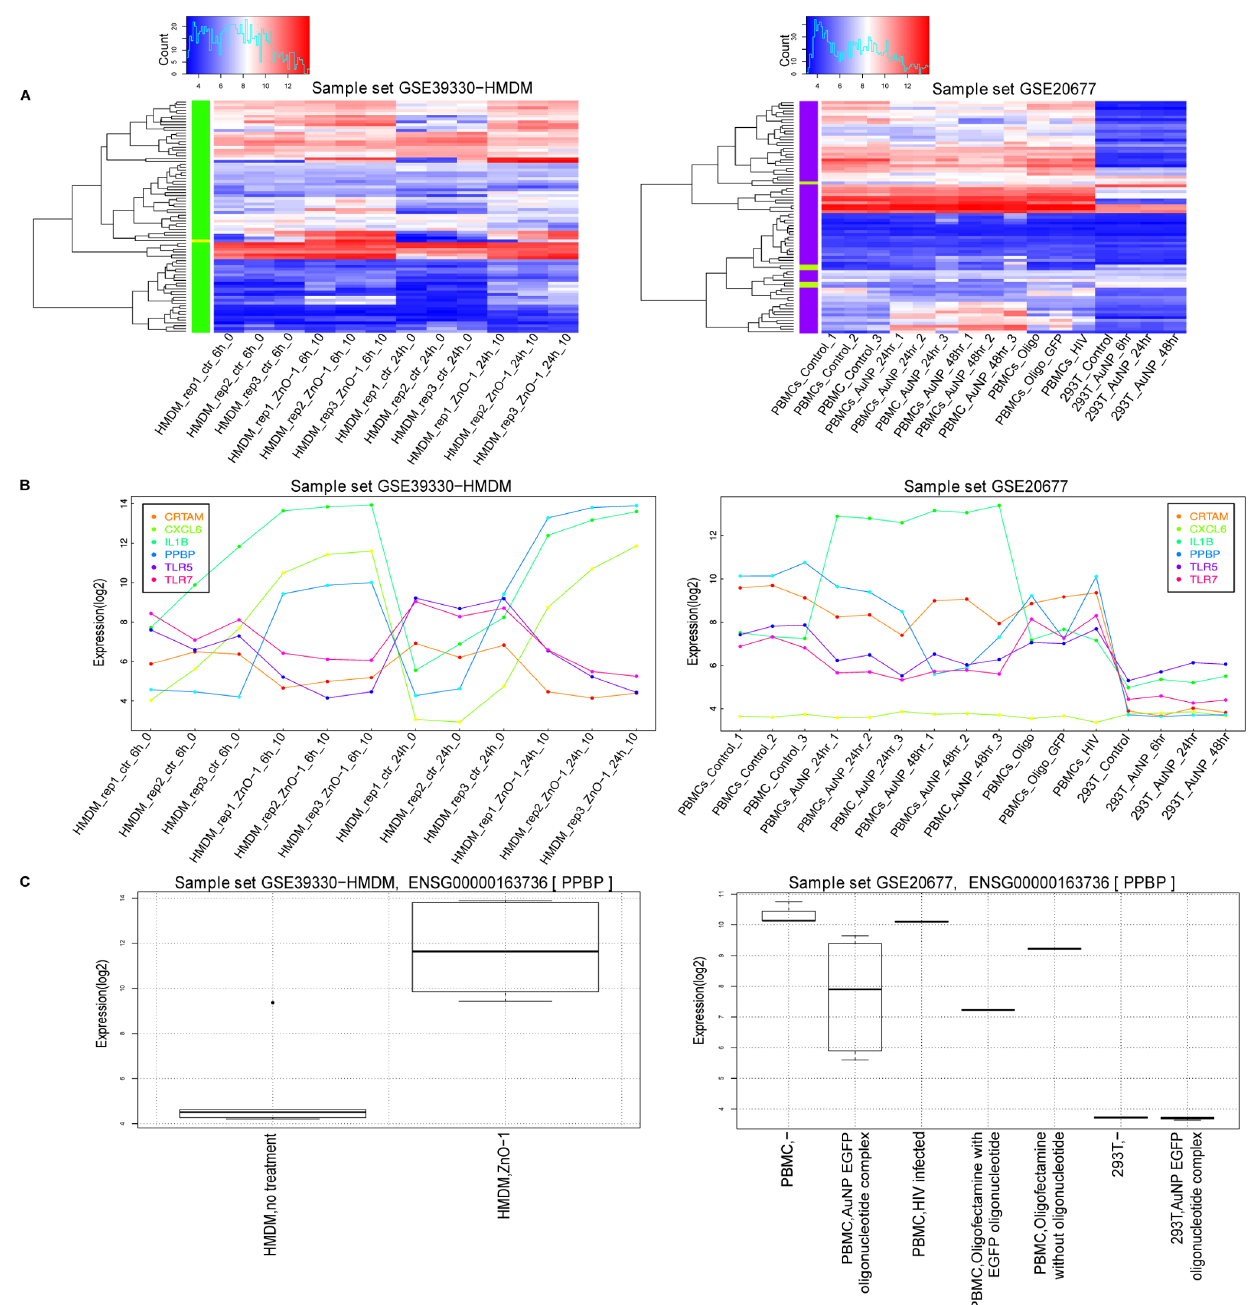
Figure 3. Gene-centric visualization options in NanoMiner. 82 genes (Table S6) from ‘‘GO:0006955: immune response’’ were detected as differentially expressed genes in HMDM cells treated with 10 m g/ml ZnO-nanoparticle compared to untreated control cells at 24 hours in dataset GSE39330. A) The heatmap presentation of the expression of these genes in GSE39330 and GSE20677. B) The expression profile of the three most highly upregulated (PPBP, CXCL6, IL1B) and downregulated genes (CRTAM, TLR7, TLR5) after exposing HMDM cells with 10 m g/ml of ZnO- nanoparticle for 6 hours belonging to GO term GO:0006955: immune response plotted over all the samples in GSE39330 and GSE20677. C) Boxplots of the expression level of gene PPBP in the datasets GSE39330 and GSE20677 by